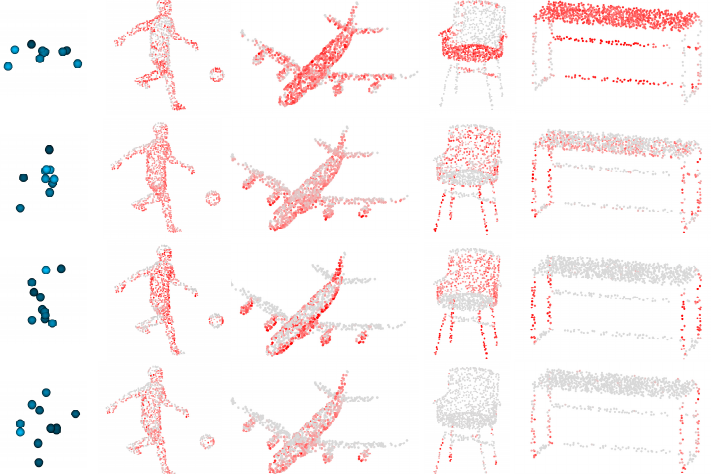
Figure 10. Visualization of the learned kernels and their corresponding activations on different objects. First column shows the learned kernels, and the rest are the activated parts on different objects (darker red means larger activated value).